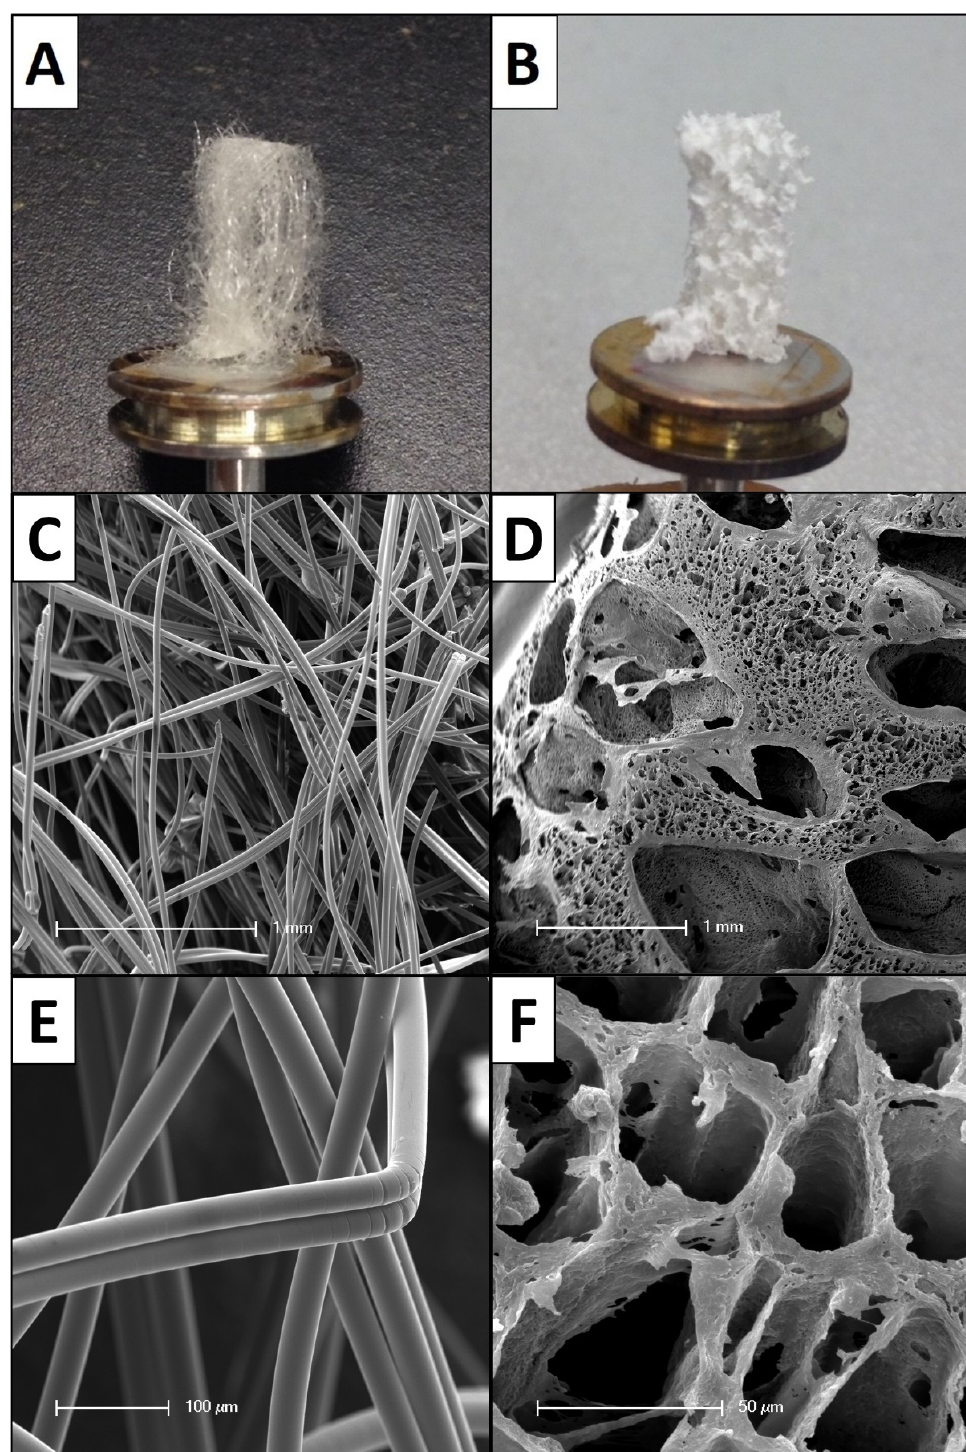
Figure 1. Architectural differences of the biomaterial forms. ( A ) Macroscopic image of a filamentous fleece on a metal carrier. ( B ) Macroscopic image of the sponge-like biomaterial on a metal carrier. ( C ) SEM overview image of the native filamentous fleece: note the random orientation of the fibers; ( D ) SEM overview image of the native sponge-like biomaterial: note the different pore sizes; ( E ) SEM close up image of the filamentous fleece: note the smooth surface structure of the fibers; ( F ) SEM close up image of the sponge-like biomaterial: note the interconnected pores and the rough surface texture.